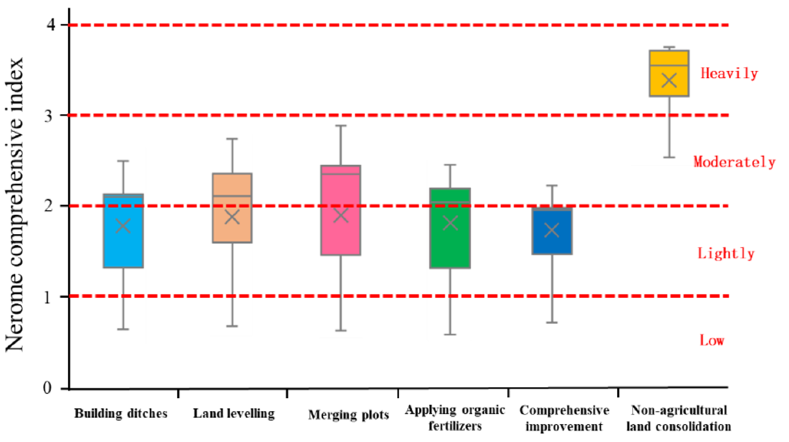
Figure 13. Evaluation results of the Merrow comprehensive pollution index in the soil of the study